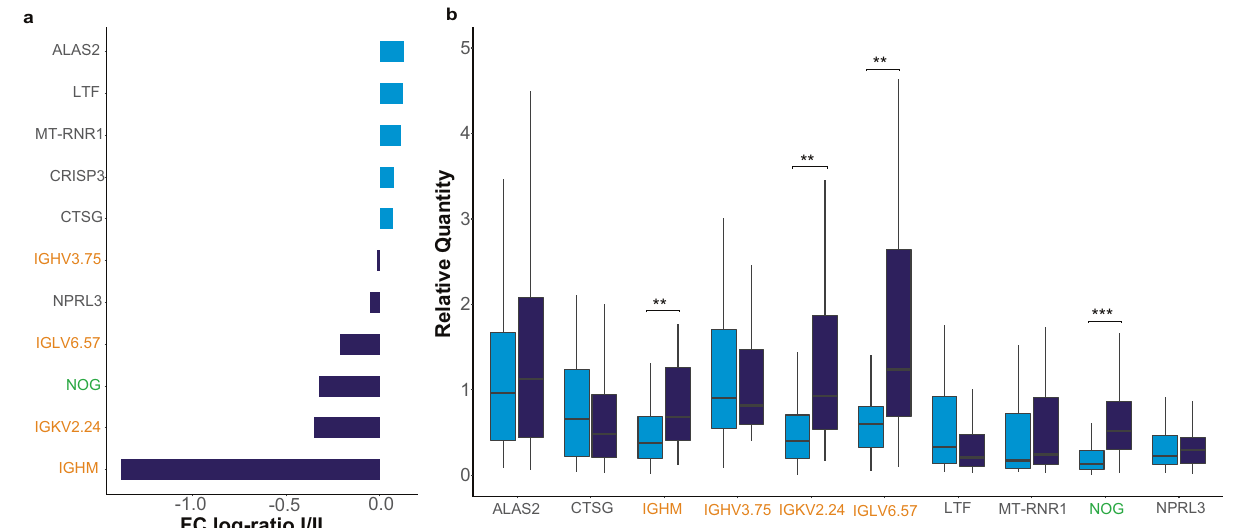
Fig. 6 Genes of interest with data based on our qPCR results of 91 patients (I = 53, II = 38) of the validation cohort. a Mean expression fold change (log2 scaled) of the signature genes between validation subgroup I (immune inactive) and II (immune active). The fold ratio was generated based on negative delta Ct values (vs GAPDH). Genes over-expressed in subgroup I are denoted by light blue bars while genes primarily expressed in subgroup II are represented by dark blue bars. b The relative quantity (RQ) of each gene of interest relative to GAPDH using a two-sided t -test with medians and signi fi cant differences shown with pI-II (IGHM) = 8.256 × 10 − 3 , pI-II (IGKV2.24) = 2.373 × 10 − 3 , pI-II (IGLV6.57) = 5.908 × 10 − 3 and pI-II (NOG) = 1.233733 × 10 − 4 . ** p < 0.01, *** p < 0.001. Vertical centre line represents the median, top and bottom bounds of the box represent the fi rst and third quartile, while the tips of the whiskers represent min and max